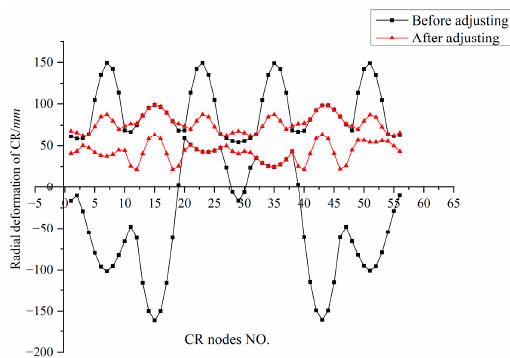
Figure 30. Envelope diagram of radial deformation of CR before and after adjusting.